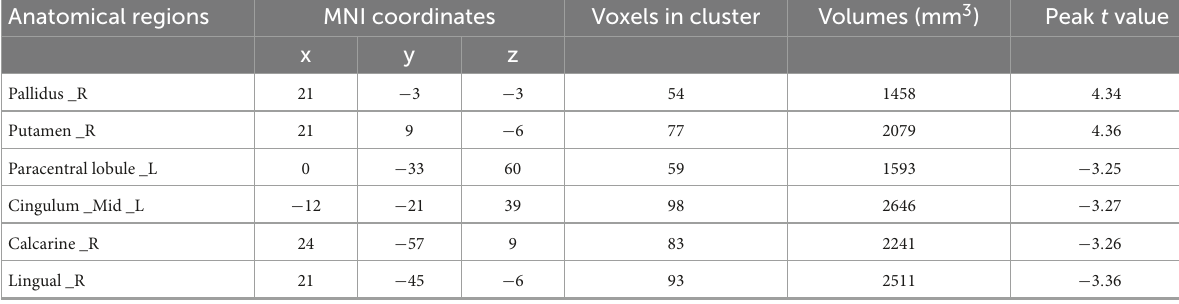
TABLE 2 Brain regions with significant differences in DC values between CTN patients and